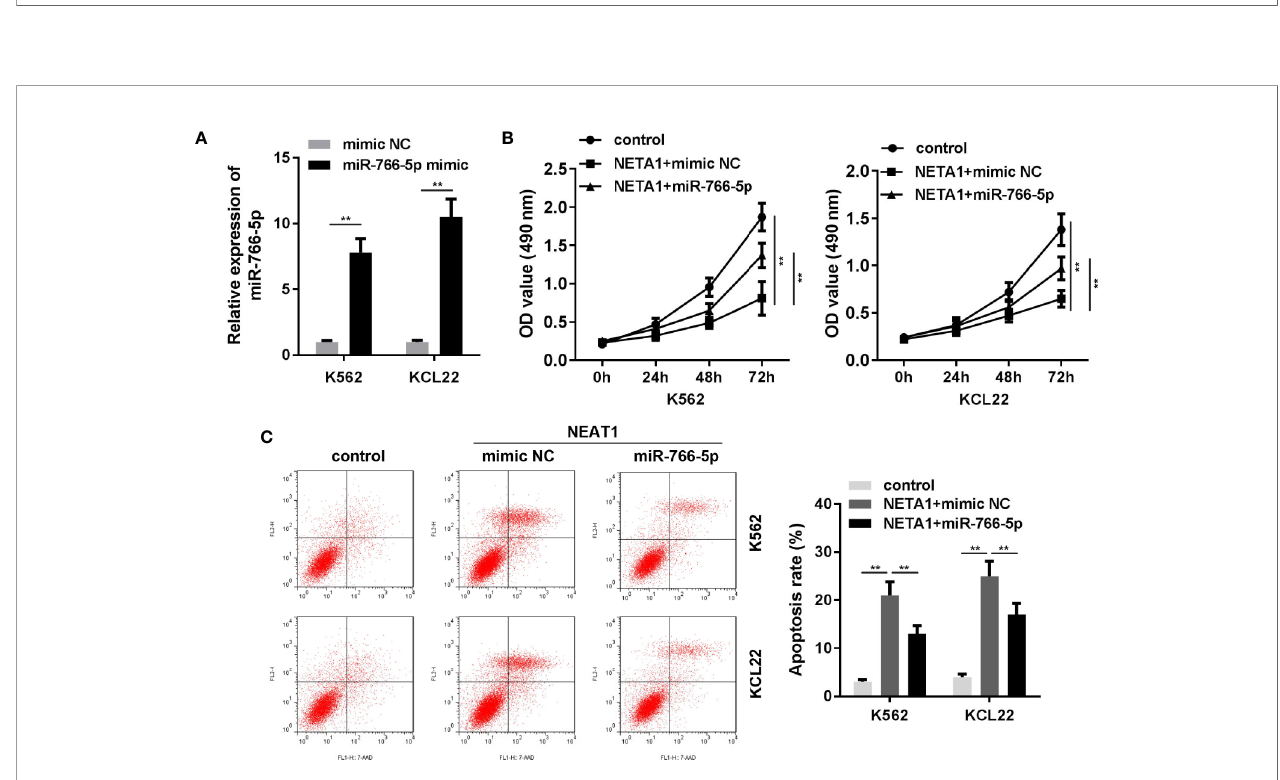
FIGURE 4 | Overexpressed miR-766-5p enhances cell viability and inhibits the apoptosis of CML cells. (A) The transfection ef fi ciency of miR-766-5p in CML cells. (B) The cell viability and (C) apoptosis of CML cells. **P < 0.01 vs. mimic NC, control or NEAT1 + mimic NC. NEAT1, lncRNA nuclear enriched abundant transcript 1; NC, negative